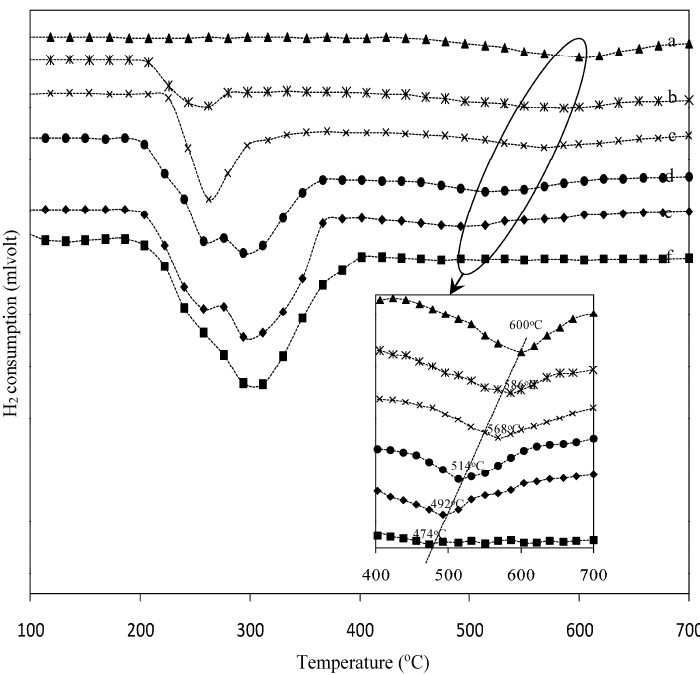
Figure 6. Temperature program reduction (TPR) profiles of 18 wt. % Ni 1 − x ‐ Cu x /Al 2 O 3 ( x = ( a ) 0, ( b ) 0.1, ( c ) 0.3, ( d ) 0.5, ( e ) 0.7, ( f ) 1.